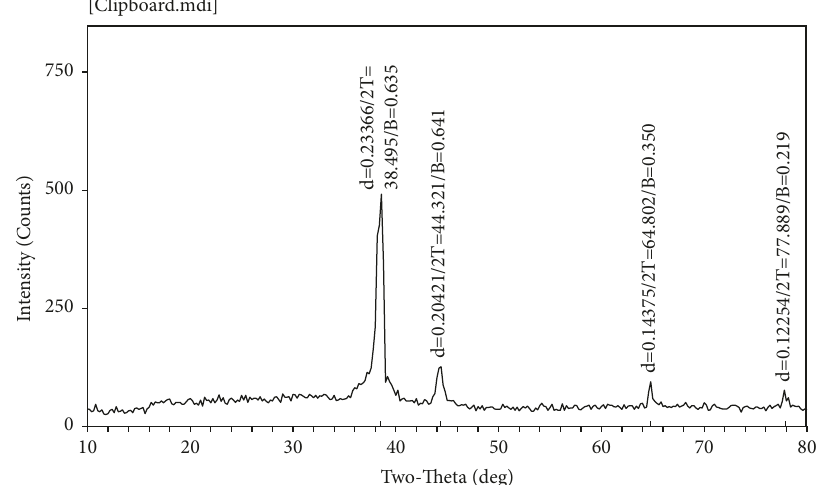
Figure 4: XRD pattern formed after reaction of M. oleifera leaves